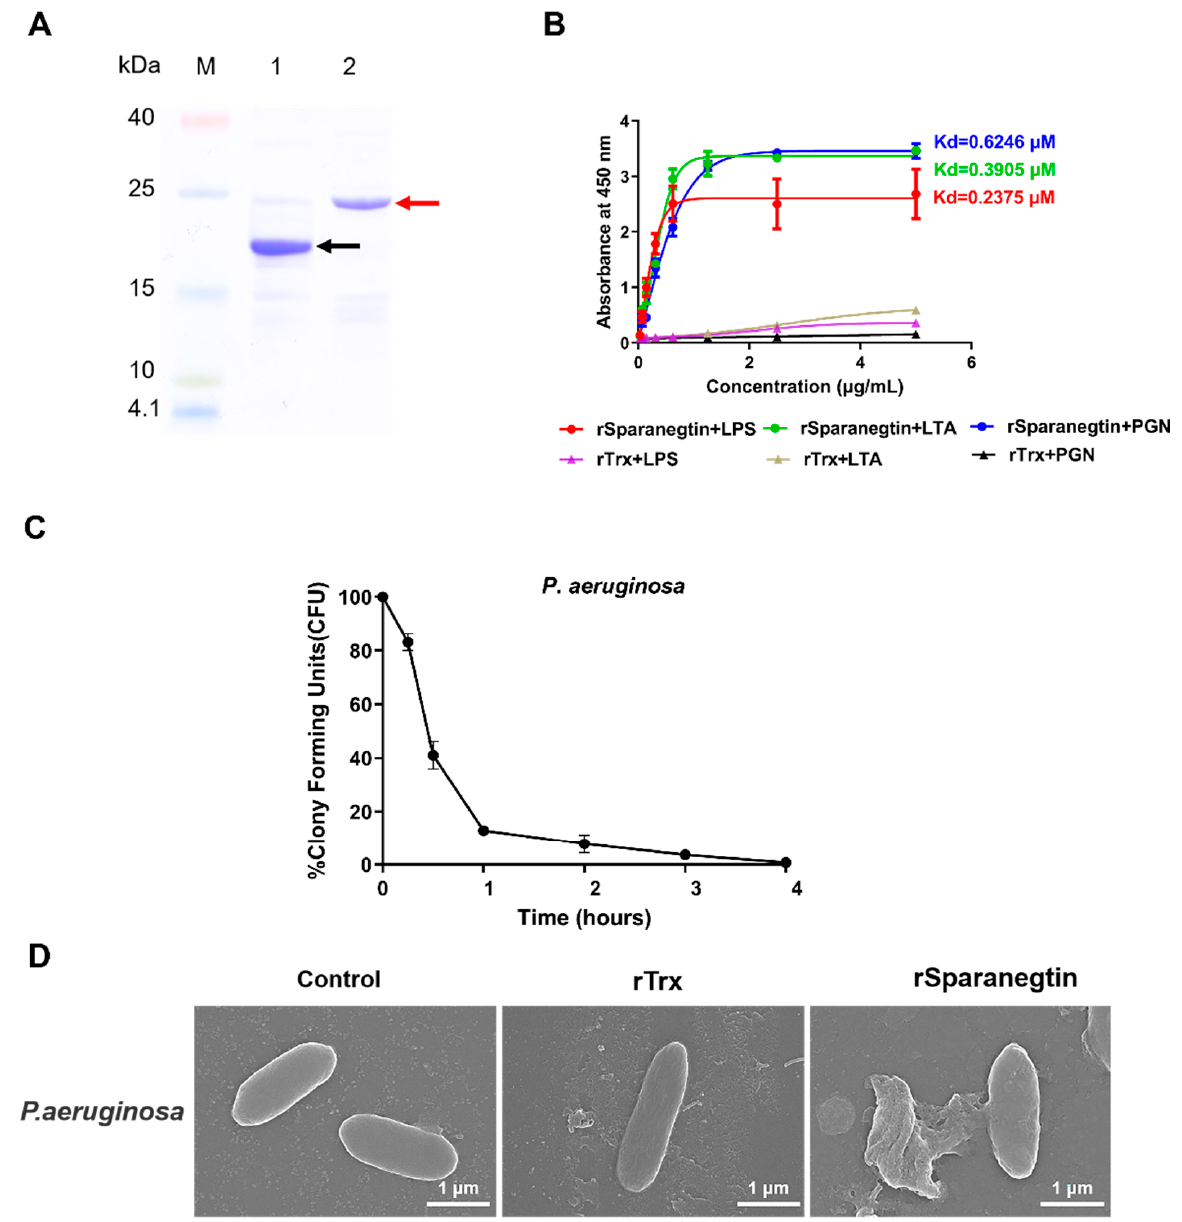
Figure 3. Binding activity and antibacterial mechanism of rSparanegtin. Expression and purification of recombinant Sparanegtin. Lane M: protein molecular standard; lane 1: purified rTrx; lane 2: purified rSparanegtin; the arrow indicates the size of the protein ( A ). Binding activity of rSparanegtin and rTrx to PAMPs (LTA for lipoteichoic acid, LPS for lipopolysaccharide, PGN for peptidoglycan) ( B ). Time-killing curves of P. aeruginosa treated with rSparanegtin ( C ). P. aeruginosa was suspended in culture media supplemented with PBS, rTrx, or rSparanegtin and observed by a scanning electron microscopy (SEM) ( D ). Table 1. Antimicrobial activity of rSparanegtin.